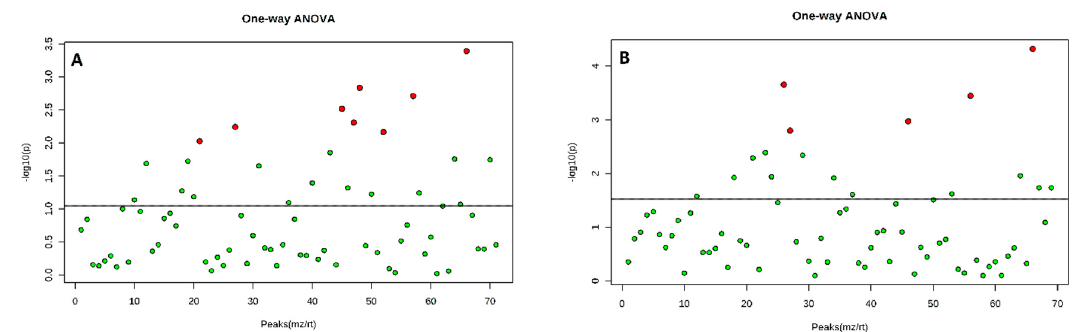
Figure 2. Volatile organic compounds collected from Hybrid Tea flowers after application of benzyladenine BA ( A ) and naphthalene acetic acid NAA ( B ), the red dots represent the volatile compounds which are significantly ( p < 0.05) different to the total collected volatile compounds. Principal component analysis PCA analyses were used with one-way ANOVA.